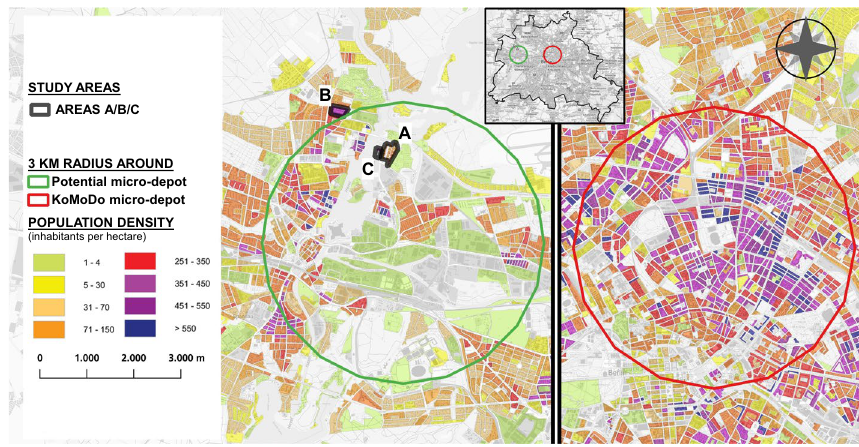
Fig. 9 Population density in the study area (left) and the operational area of the KoMoDo micro-depot (right). Data source: Statistics Office Berlin/Brandenburg, licenced under CC-BY-3.0-Namensnennung, URL: https:// creat iveco mmons. org/ licen ses/ by/3. 0/